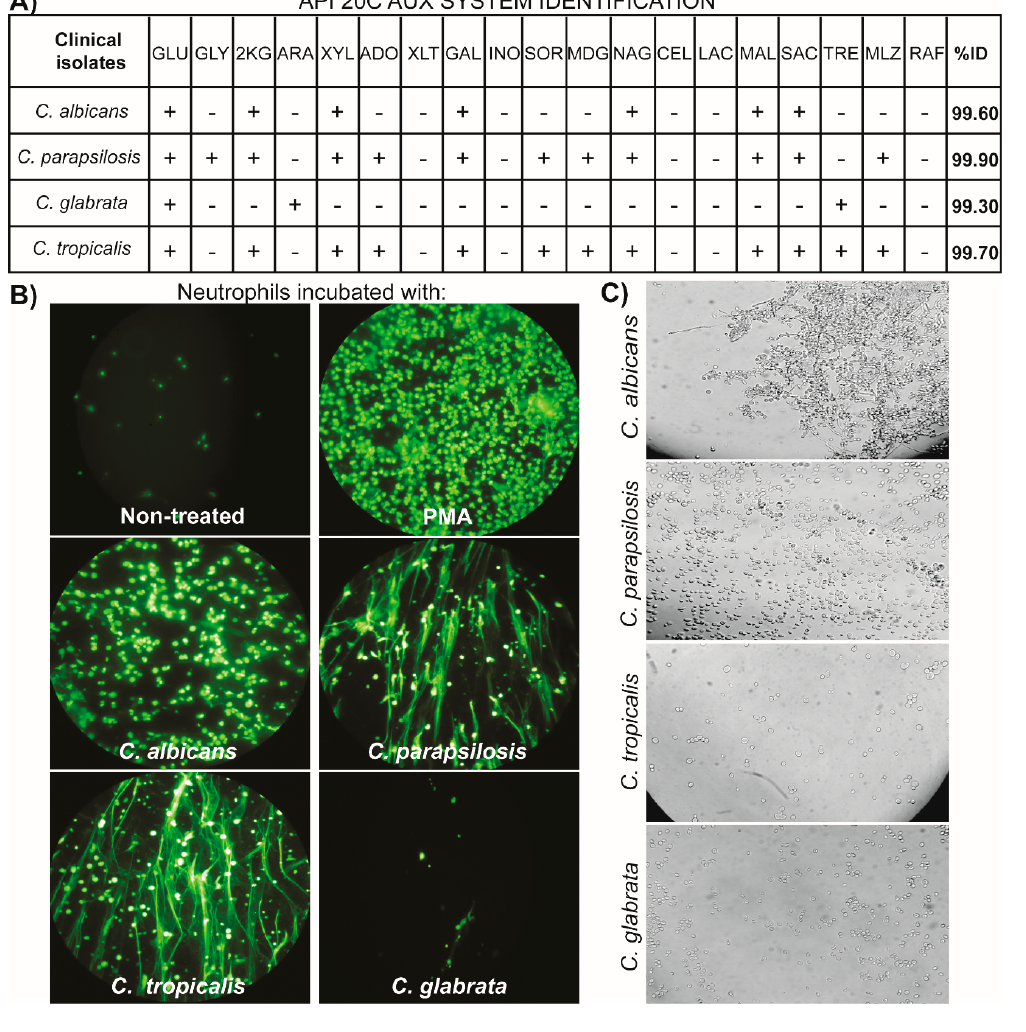
Figure 1. Candida isolates can promote NETs formation regardless its capacity to form filamentous structures. ( A ) Identification profiles of Candida isolates through their ability to use carbon substrates by API 20C AUX. ( B ) Neutrophils were incubated with C. albicans , C. parapsilosis , C. tropicalis , or C. glabrata isolates (MOI 0.2:1), PMA (40 nM) or non-treated (NT). Sytox Green was added after 180 min of incubation to detect extracellular DNA. A representative image of NETs induced by each strain is shown. ( C ) Filamentous structures are observed in Candida albicans isolates, but not in those of C. parapsilosis , C. tropicalis , or C. glabrata . A representative image of each species is shown.